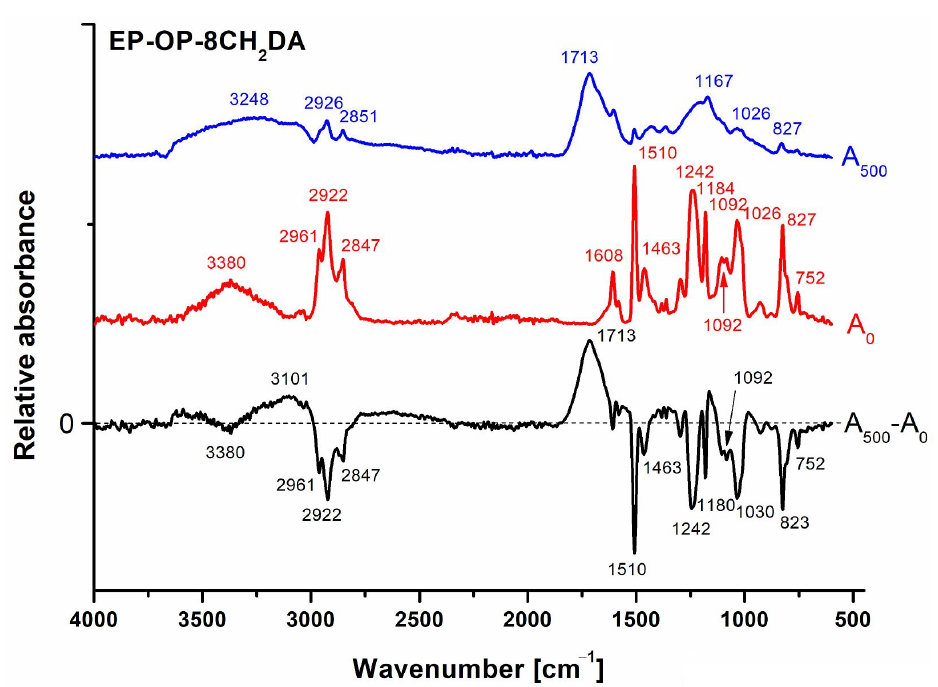
Figure 8. FT-IR spectra of the S–IPN EP–OP–8CH 2 DA recorded before (A 0 ) and after 500 h exposure (A 500 ) and the difference spectrum (A 500 –A 0 ).